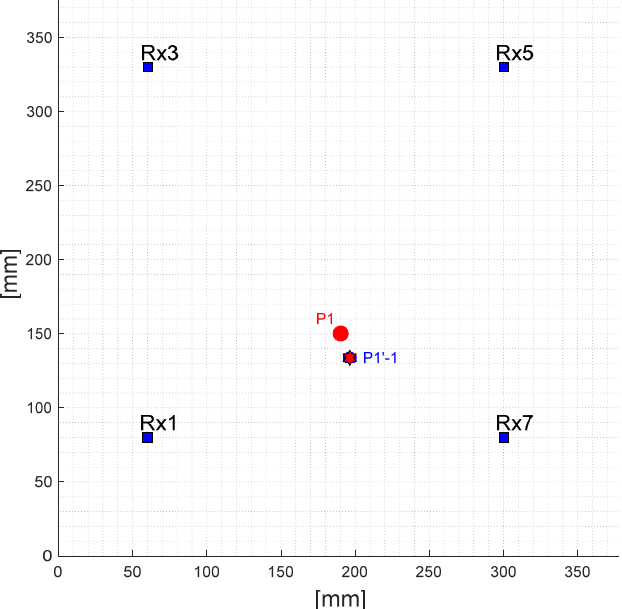
Figure 8. Position of impact P1 (red circle) inside the ROI with coordinates x i = 190 mm, y i = 150 mm. The detected impact position P1 ′ -1 (red star) with coordinates x p = 196 mm, y p = 134 mm was obtained by processing the ultrasonic signals acquired by only four sensors (Rx1, Rx3, Rx5, and Rx7). Reproduced from [24].